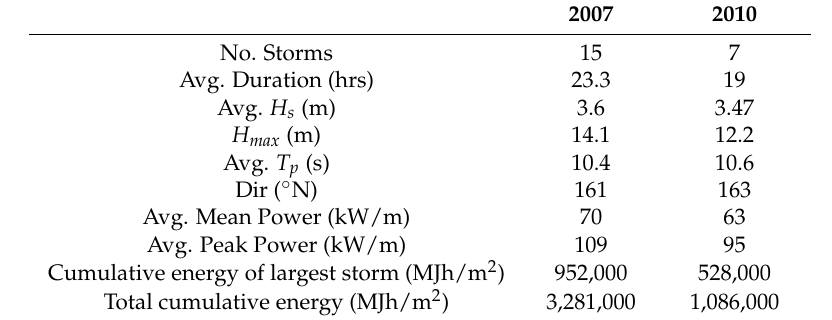
Table 3. Storm characteristics for the six months prior to each bathymetric survey calculated from hourly wave data.